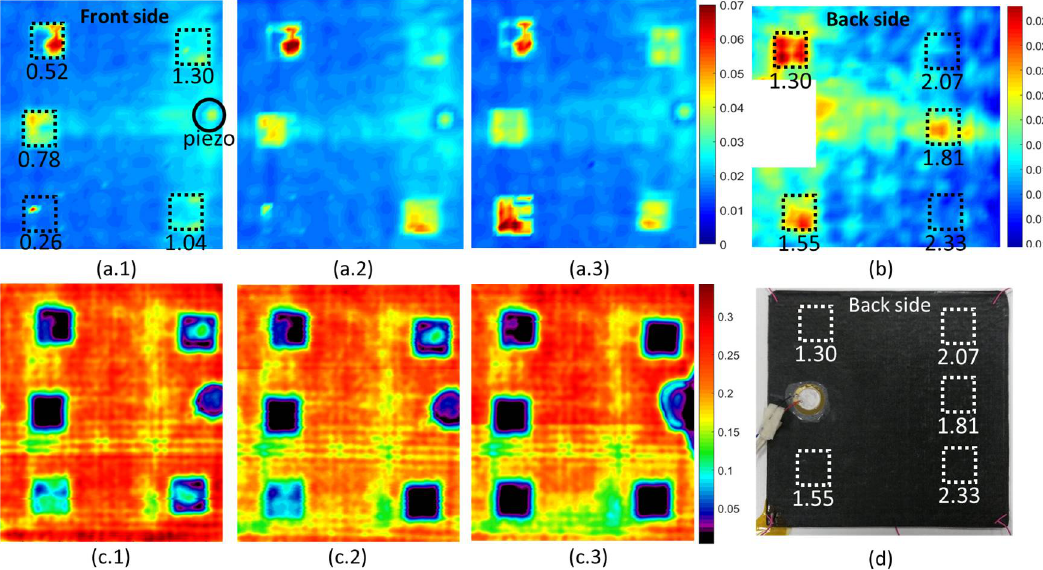
Figure 2. ETFE inserts: FBD over entire excitation bandwidth for ( a ) back side scan and ( b ) front side scan (remark the difference in the colorscale limits) and ( c ) ultrasonic C-scan before and after impact cycles; ( d ) Sample